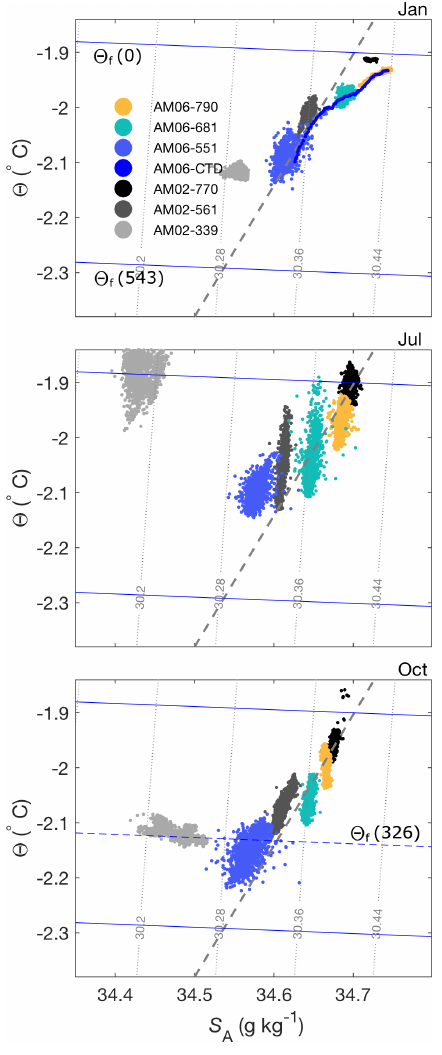
Figure 5. (cid:50) – S A plots for January, July, and October of AM06 (2010) and AM02 (5 year composite of years 2001, 2003–2006). Freezing temperature curves at the surface (0dbar), AM06 interface (543dbar), and AM02 interface (326dbar, bottom panel only) pres- sure are also shown. The dashed grey line is the meltwater mixing line from Fig. 3.